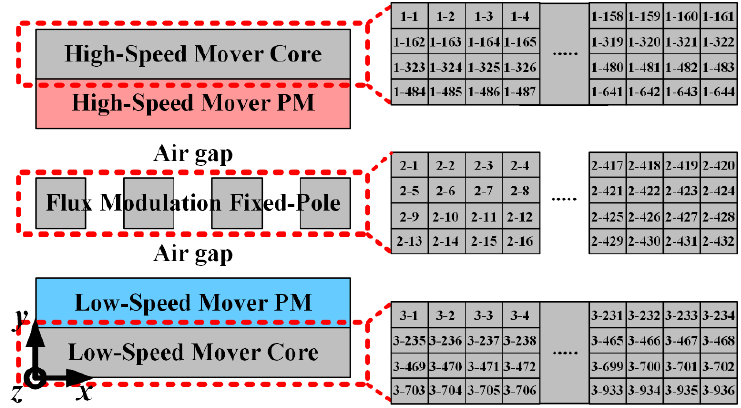
Figure 4. Segmentation analysis of core area.